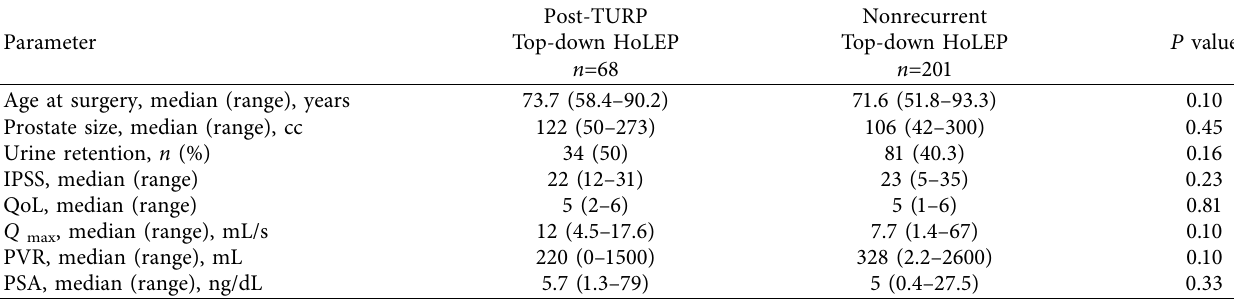
Table 1: Preoperative